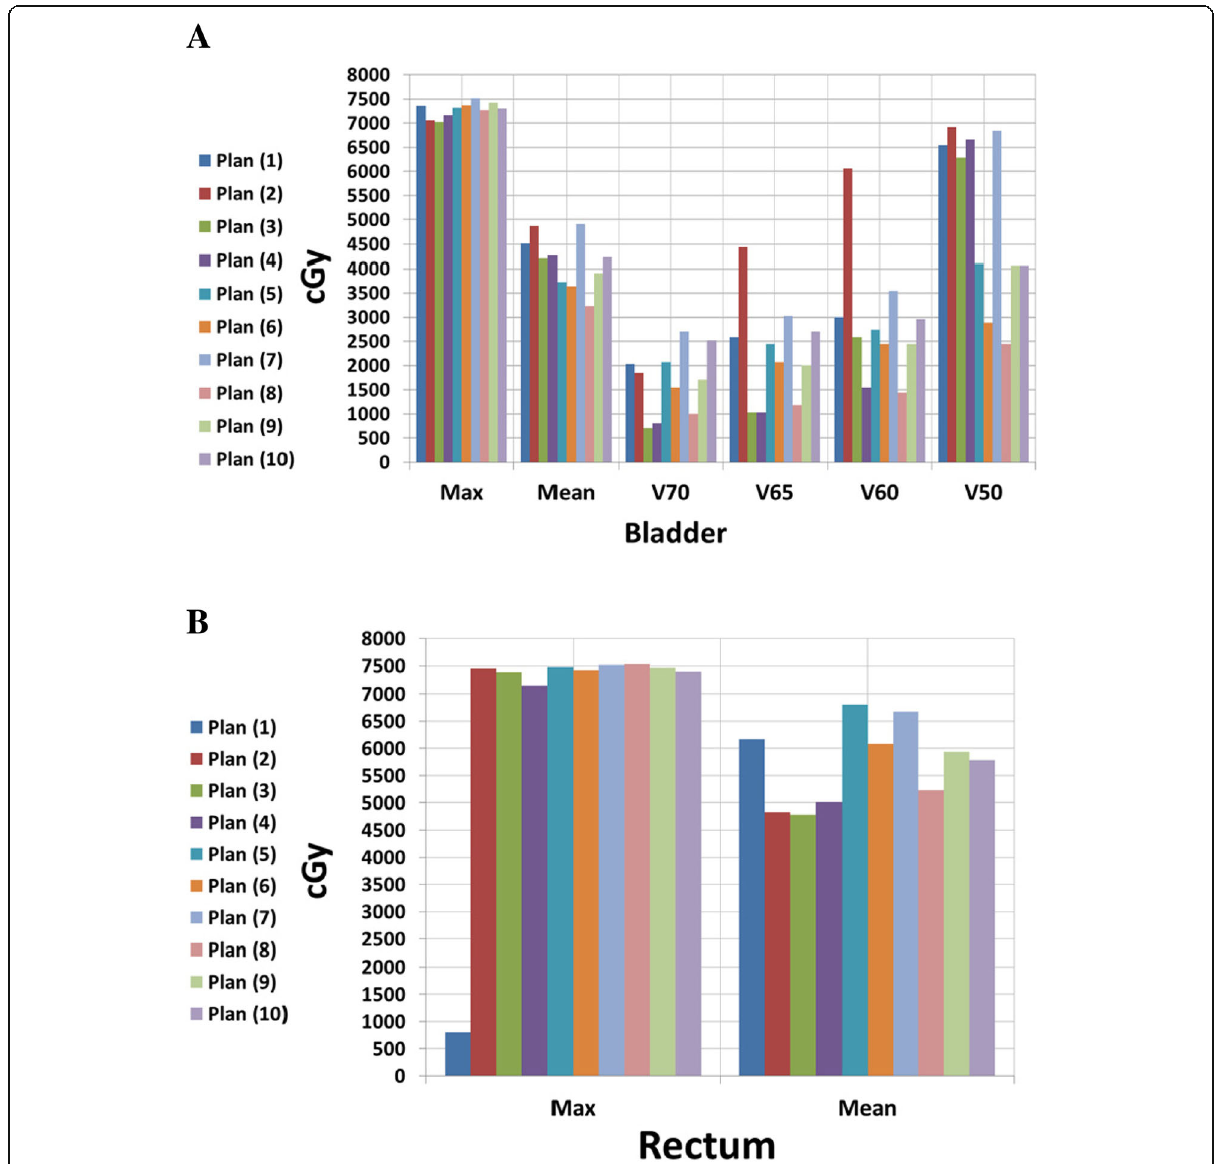
Fig. 5 DVH analysis for the ten plans regarding a the bladder (max, mean, V70, V65, V60, and V50 doses) and b rectum (max,